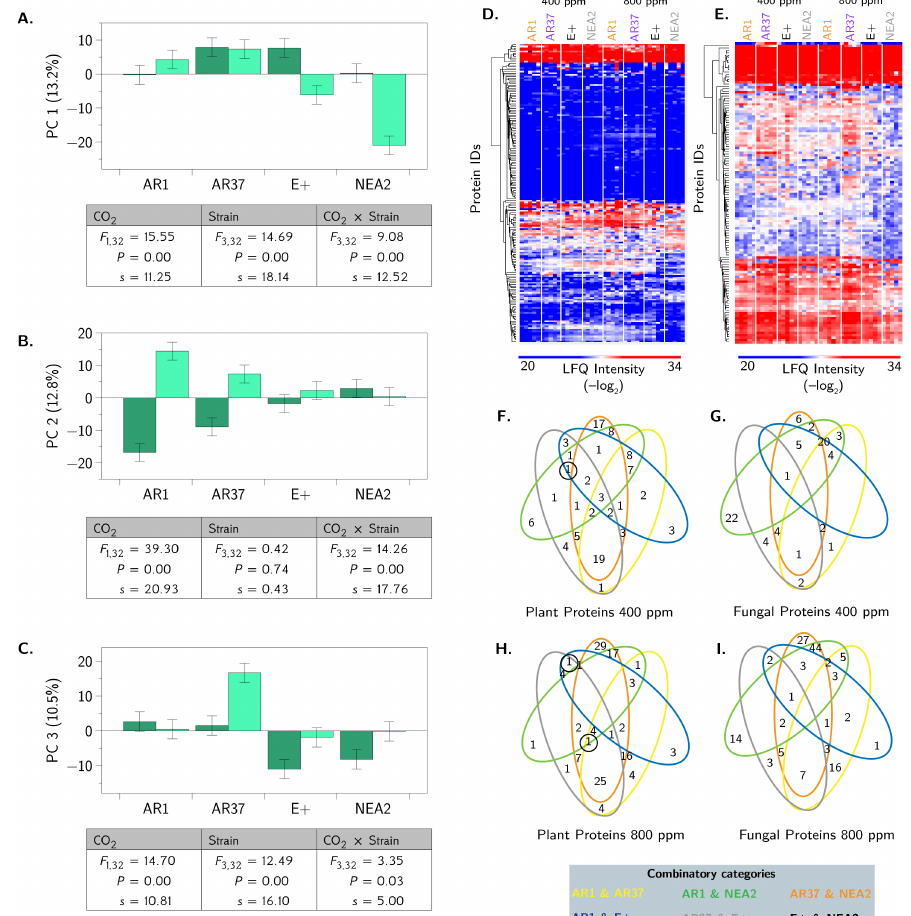
Figure 6. Quantitative proteomics profiling of endophyte-specific response to colonization of L. perenne with epichloid strains. ( A – C ) Principal components analysis of L. perenne colonized with epichloid strains (AR1, AR37, E+, NEA2); dark bars denote 400 ppm CO 2 , light bars denote 800 ppm CO 2 . Shown are the means and standard errors. ( D ) Heat map of hierarchical clustering by Euclidean distance for plant proteins that differed among the epichloid strains and at normal (400 ppm) and elevated (800 ppm) CO 2 levels. ( E ) Heat map of hierarchical clustering by Euclidean distance for fungal proteins that differed among the epichloid strains and at normal (400 ppm) and elevated (800 ppm) CO 2 levels. ( F , G ) Venn diagrams of common and unique differences in plant and fungal proteins at 400 ppm CO 2 . ( H , I ) Venn diagrams of the number of common and unique differences in plant and fungal proteins at 800 ppm CO 2 . The numbers in F–I indicate the number of proteins with large differences in abundance, as evaluated by Student’s t -tests, p < 0.05, FDR = 0.05, S 0 = 1. Below each graph are the results from the corresponding ANOVA. We also report the Shannon information transformation, s